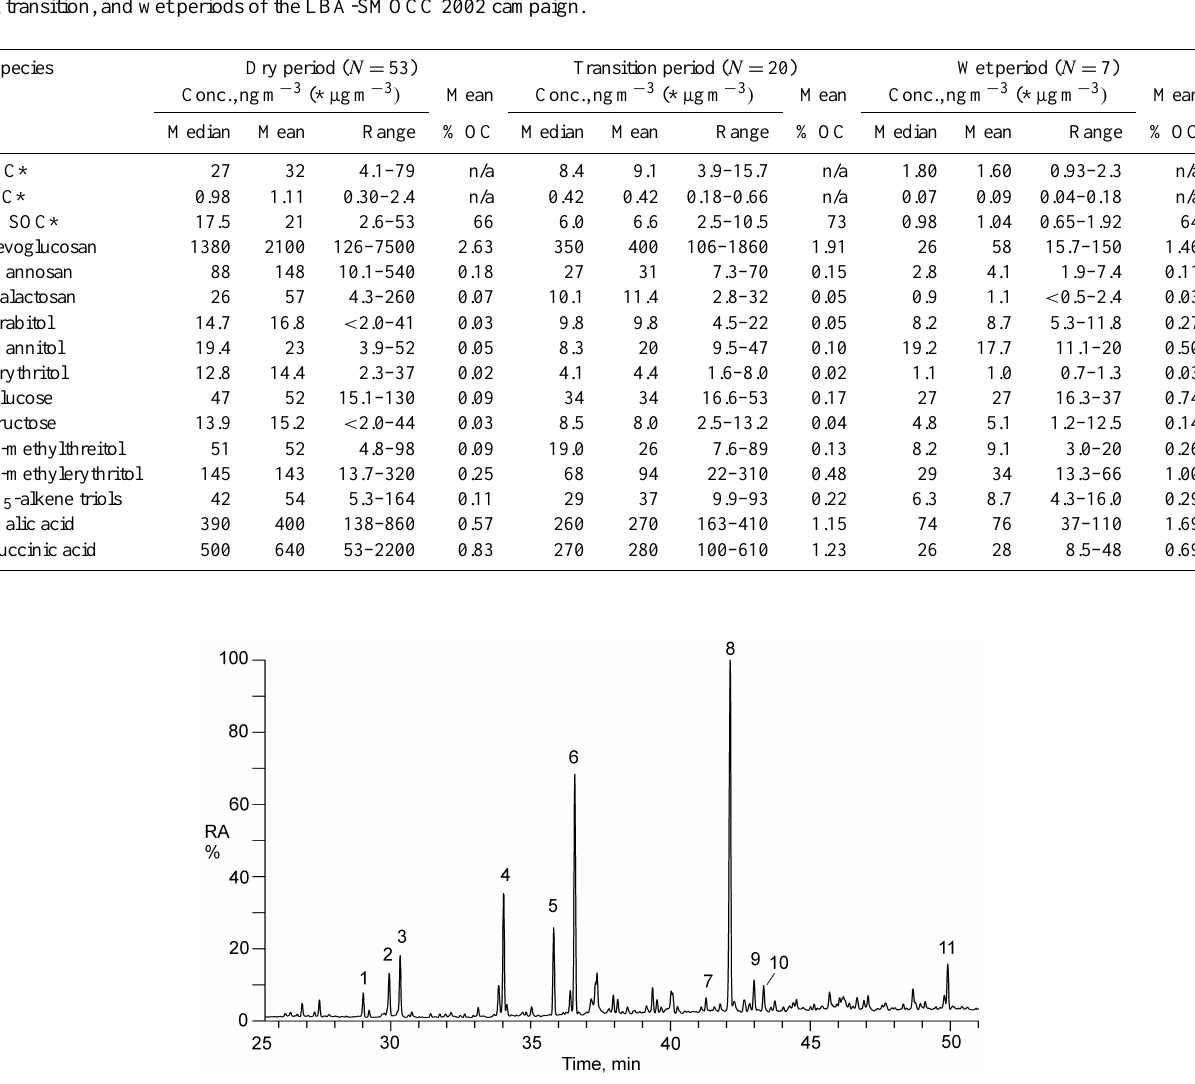
Table 1. Median and mean concentrations and concentration ranges for OC, EC, WSOC, and selected organic species (and mean percentages of the OC attributable to the carbon in the organic compounds) in the front filters of the fine size fraction of the HVDS filter samples for the dry, transition, and wet periods of the LBA-SMOCC 2002 campaign.